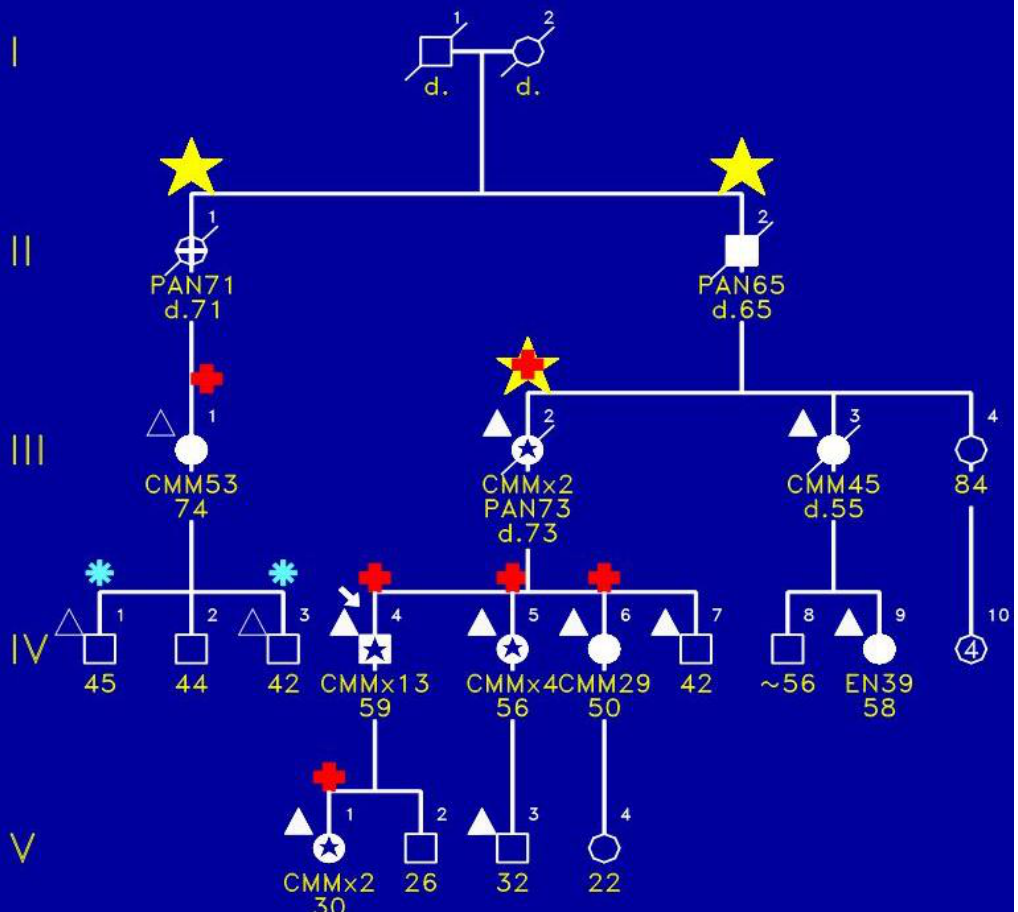
Figure 1. Pedigree of FAMMM syndrome with yellow star indicating pancreatic cancer, red + sign showing presence of CDKN2A pathogenic mutation, blue asterisk indicating tested but no pathogenic mutation, and triangles showing typical FAMMM cutaneous